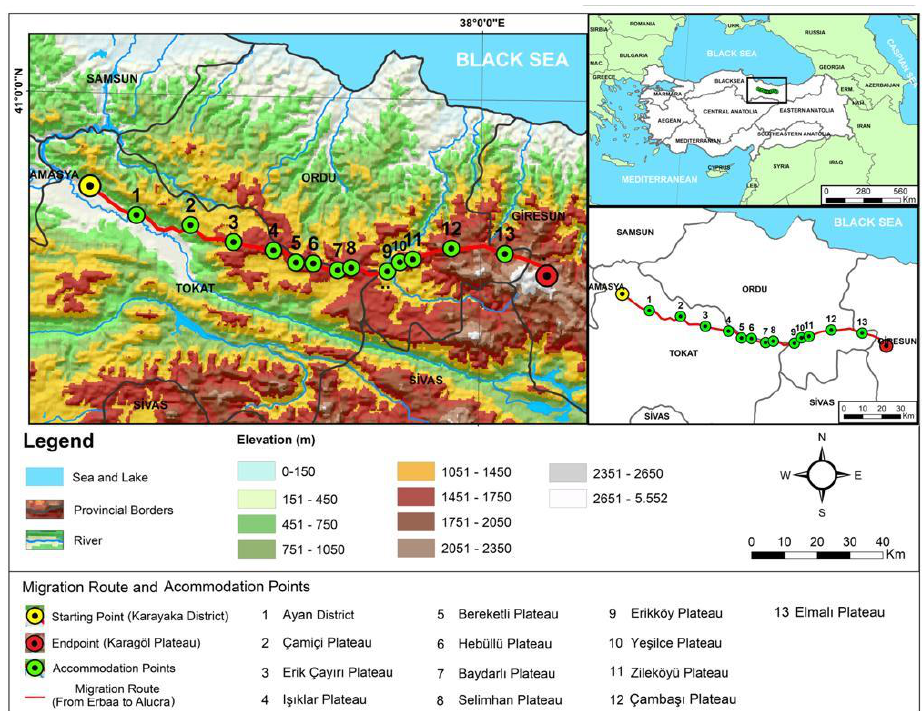
Figure 1. Study area location with migration route.